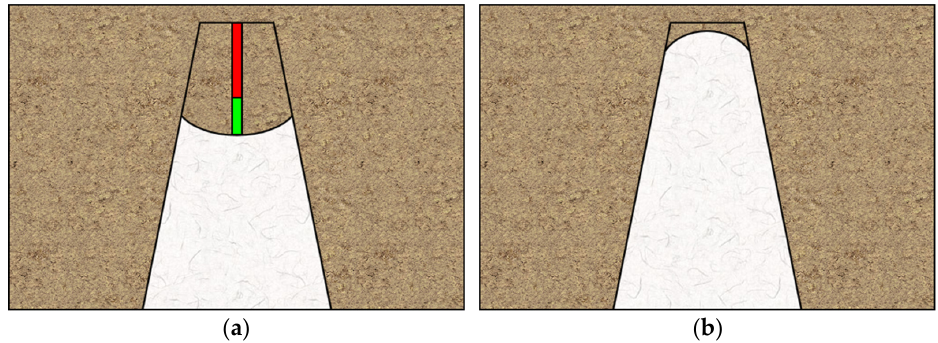
Figure 3. Cavity forming procedure: ( a ) cutting hole blasting and ( b ) center hole blasting.